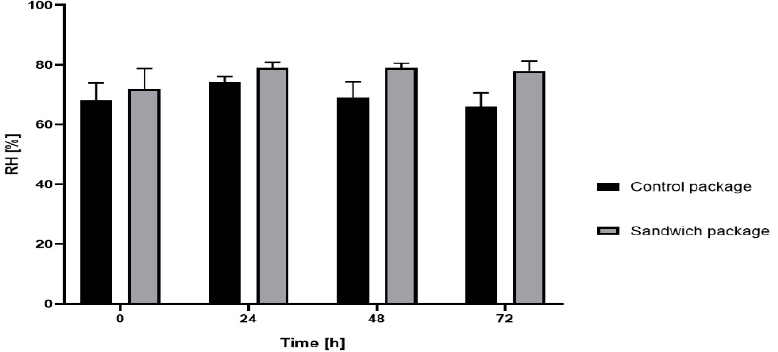
Figure 3. Relative humidity (RH) inside the paper and sandwich packaging after storage.